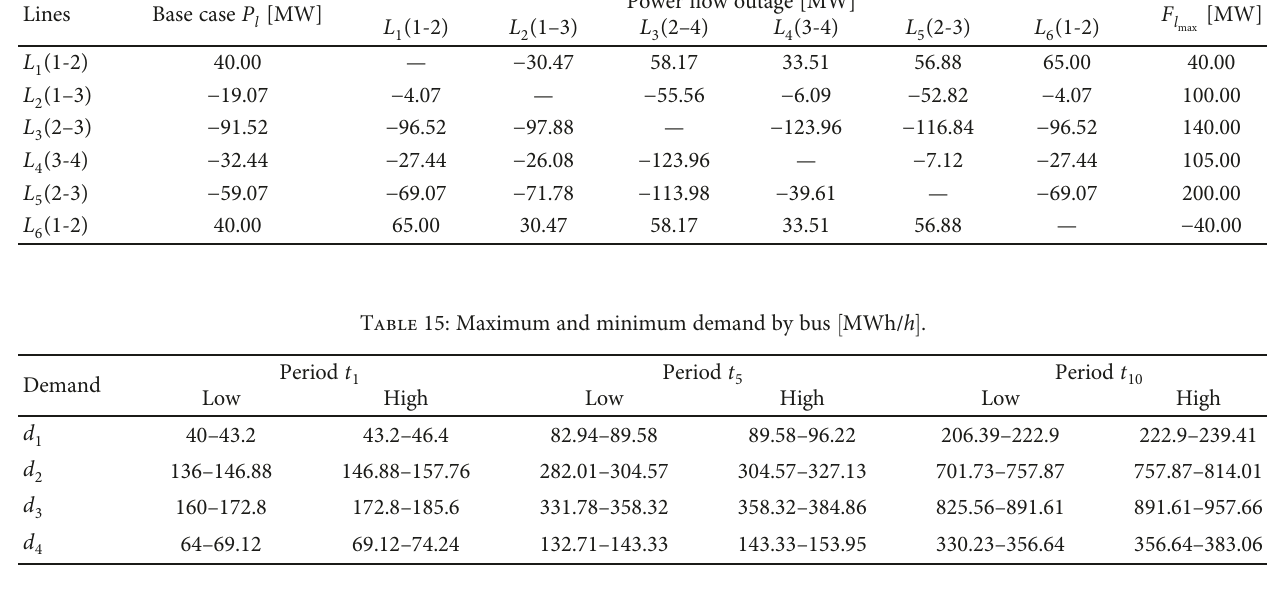
Table 16 indicates that the conventional candidate unit c